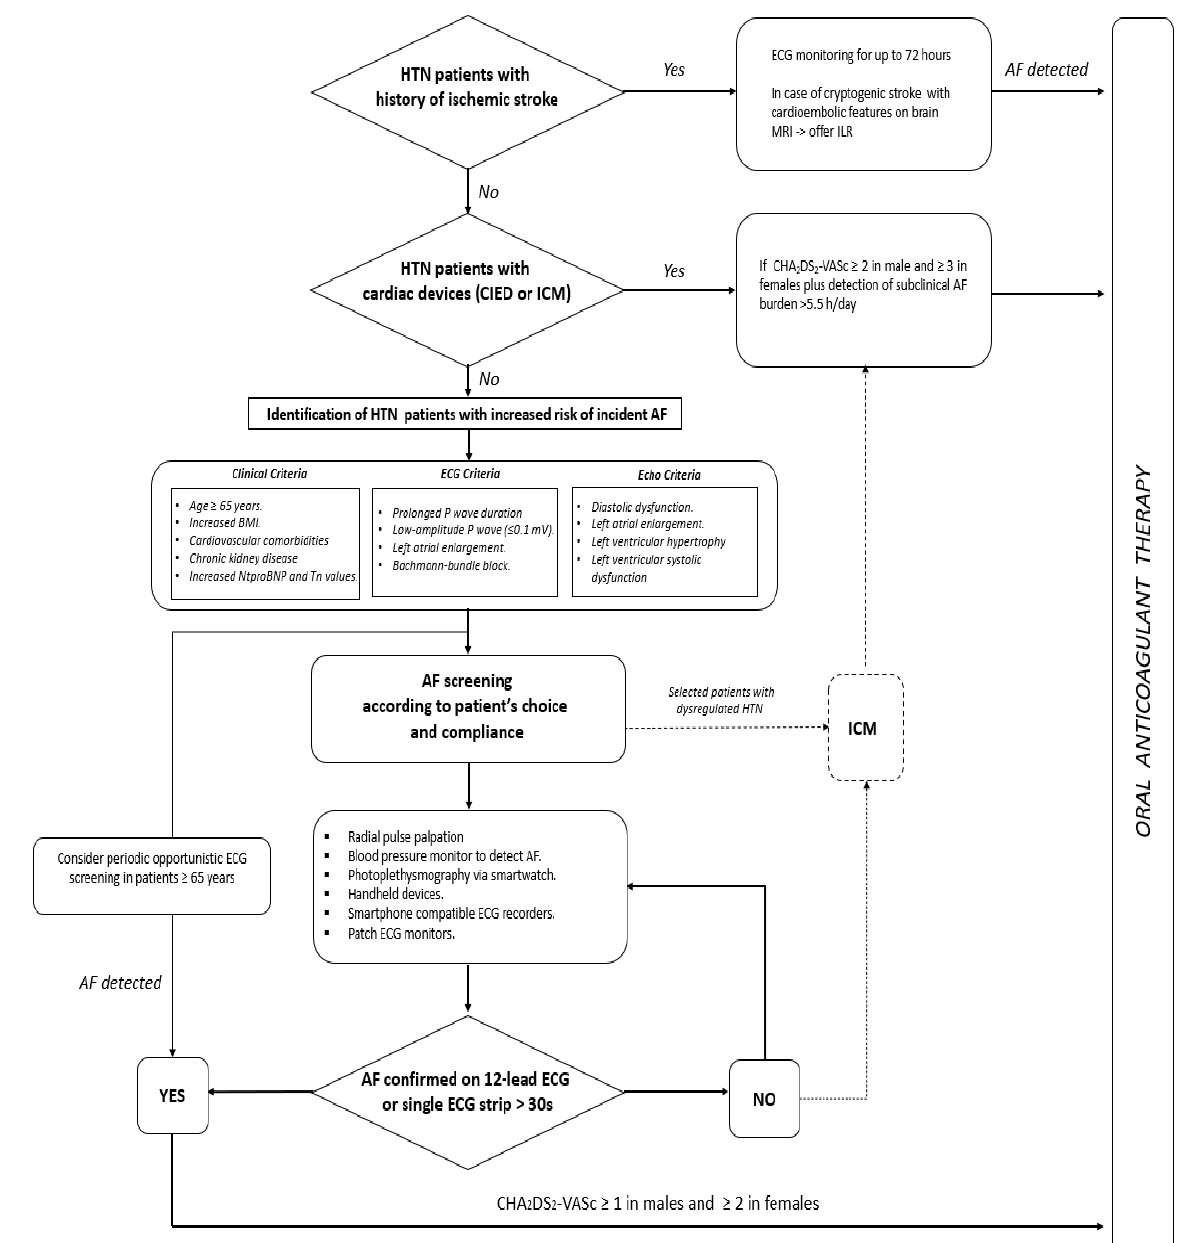
Figure 4. Proposed algorithm for early detection and management of silent and subclinical atrial fibrillation episodes. AF = atrial fibrillation; CIED = cardiac implantable electronic devices; ICM = internal cardiac monitor; ILR = internal loop recorder; HTN = hypertension.